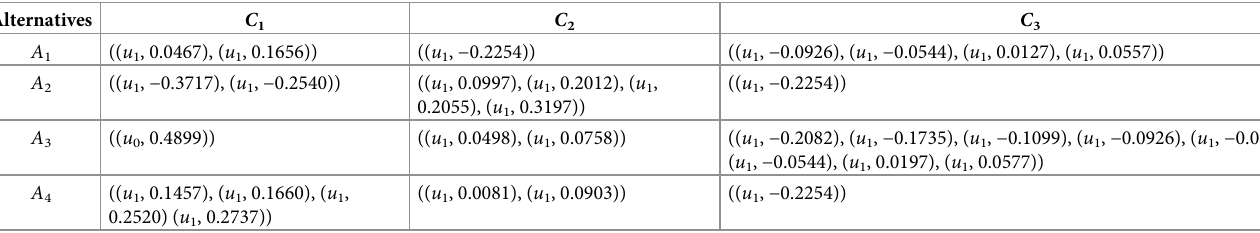
Table 1. H2FLSs aggregated judgment matrix.